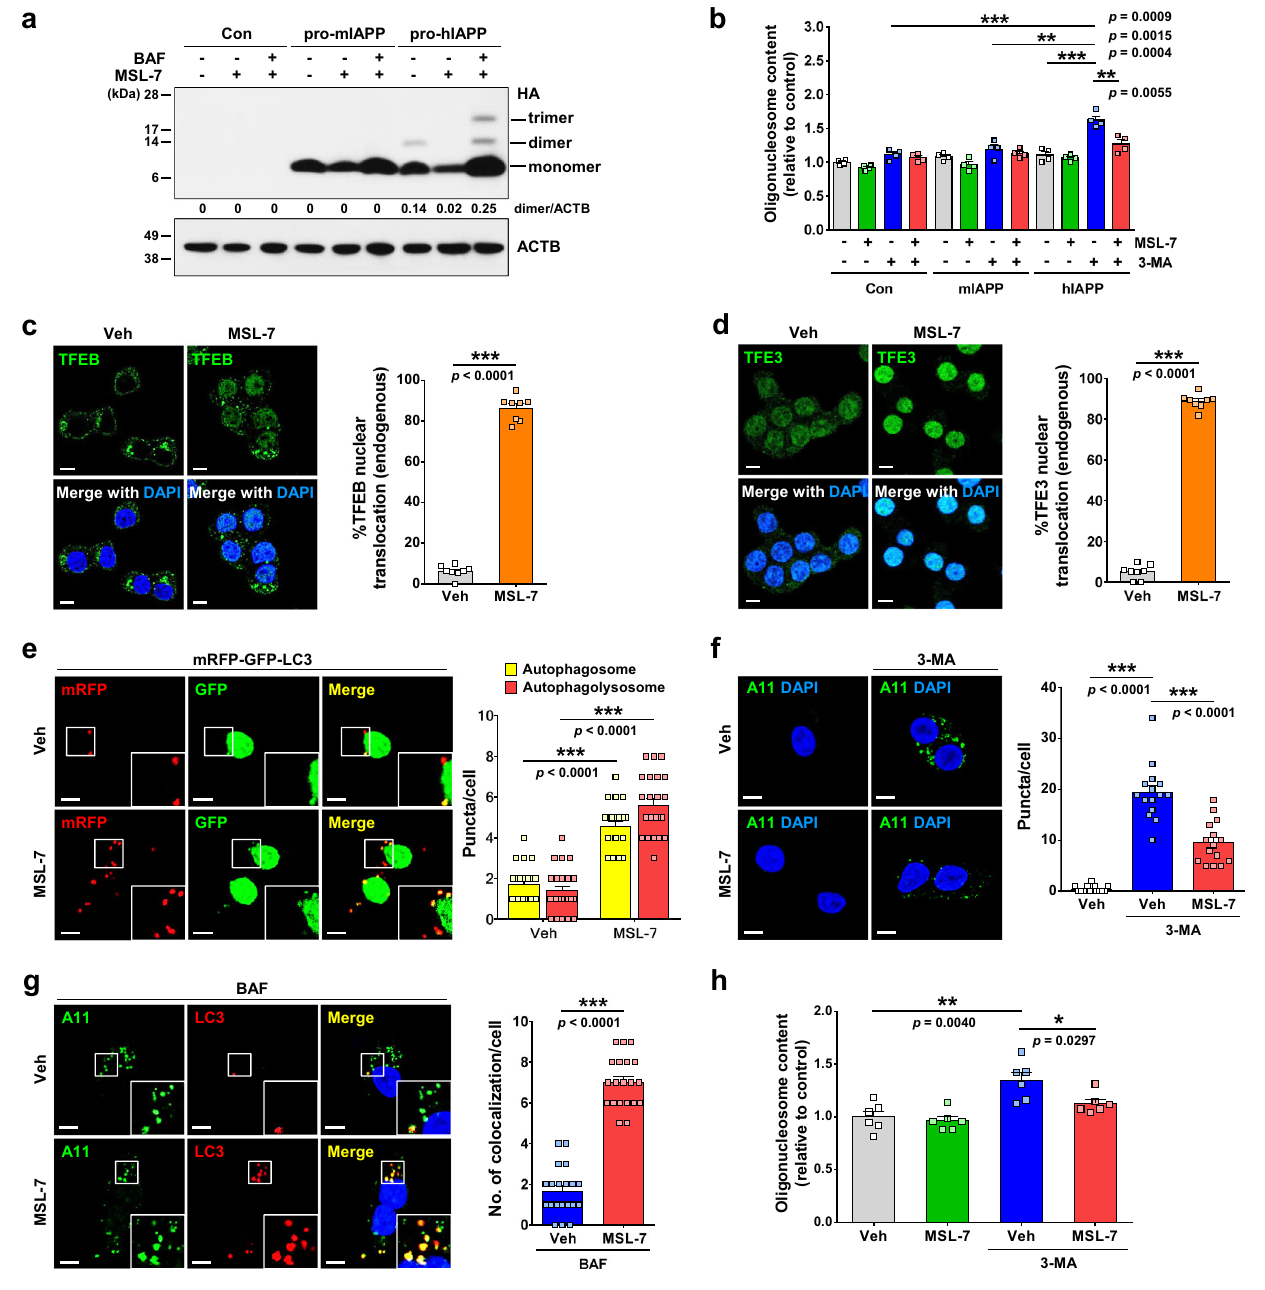
Fig. 2 hIAPP/sIAPP oligomer clearance by MSL-7. a Prepro-mIAPP-HA- transfected or Prepro-hIAPP-HA -transfected INS-1 cells were treated with MSL-7 in the presence or absence of ba fi lomycin A1 (BAF). Lysate was subjected to immunoblotting using anti-HA or anti- β -actin antibody (ACTB). Numbers indicate fold changes of hIAPP dimer normalized to ACTB bands. (Con, control-transfected). b Prepro-mIAPP-HA- transfected or Prepro-hIAPP-HA - transfected cells were treated with MSL-7 in the presence or absence of 3-MA. Oligonucleosome content was determined ( F = 19.5, df treatment = 11, df residual = 36). c – d MSL-7-induced nuclear translocation of TFEB ( c ) and TFE3 ( d ) in monkey islet cells was counted ( t = 33.2, df = 14 in c ; t = 45.7, df = 14 in d ) (right of c , d ). Representative pictures are presented (left of c , d ). e mRFP-GFP-LC3 -transfected monkey islet cells were treated with MSL-7. The numbers of autophagosome ( t = 9.5, df = 44) and autophagolysosome ( t = 10.9, df = 44) were counted (right). Representative pictures are presented (left). Inset images were magni fi ed to show red (autophagolysosomes) and yellow (autophagosomes) puncta. f Monkey islet cells treated with MSL-7 in the presence or absence of 3-MA were subjected to immunostaining using A11 antibody. The number of A11 + puncta was counted ( F = 86.3, df treatment = 2, df residual = 42) (right). Representative pictures are presented (left). g Monkey islet cells treated with MSL-7 in the presence of BAF, cells were immunostained using A11 and anti-LC3 antibodies. The number of LC3 puncta colocalized with A11 + oligomer was counted ( t = 13.9, df = 38) (right). Representative pictures are shown (left). Inset images were magni fi ed to shows LC3 puncta colocalized with A11 + oligomer. h Apoptosis was determined in MSL-7-treated monkey islet cells in the presence or absence of 3-MA ( F = 10.1, df treatment = 3, df residual = 20). All data in this fi gure are the means ± SEM from more than 3 independent experiments performed in triplicate. (scale bar, 5 μ m) * P < 0.05; ** P < 0.01; *** P < 0.001 by one-way ANOVA with Tukey ’ s test ( b , f , h ) and two-tailed Student ’ s t -test ( c , d , e , g ). Source data are provided as a Source Data fi